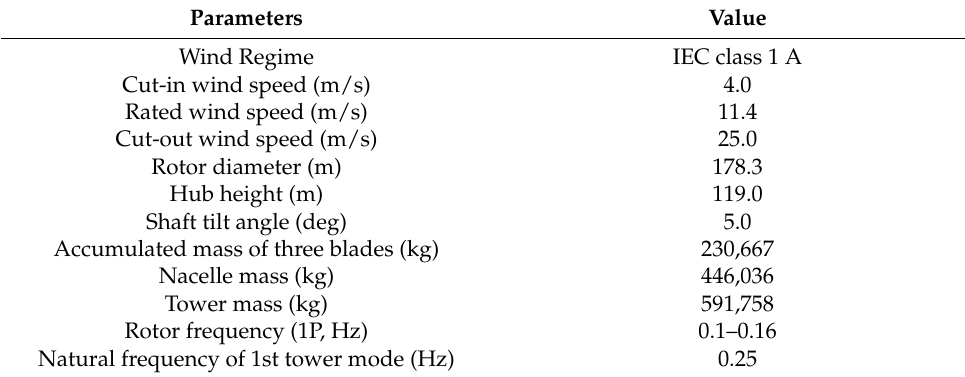
Table 1. Properties of DTU 10 MW offshore wind turbine.